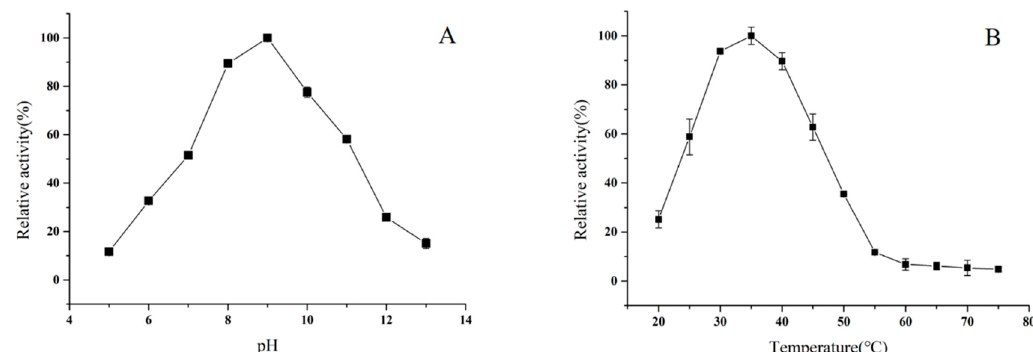
Figure 7. Effects of pH ( A ) and temperature ( B ) on BpTA-2 activity. Maximum activity in A (3.53 ± 0.11 U/mg) and B (3.50 ± 0.15 U/mg) was set as 100% and relative activity was calculated by comparison with the maximal activity.